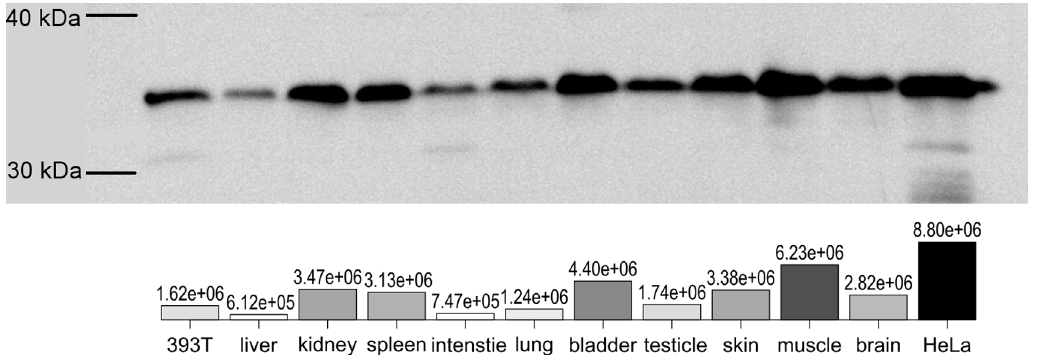
Figure 4. Examine tree shrew tissues with anti-human-GAPDH antibody. Upper: The blotting image, each lane load with 10 m g total protein. All bands in the same molecule weight level. Lower: each band’s intensity value is shown below itself as bar and